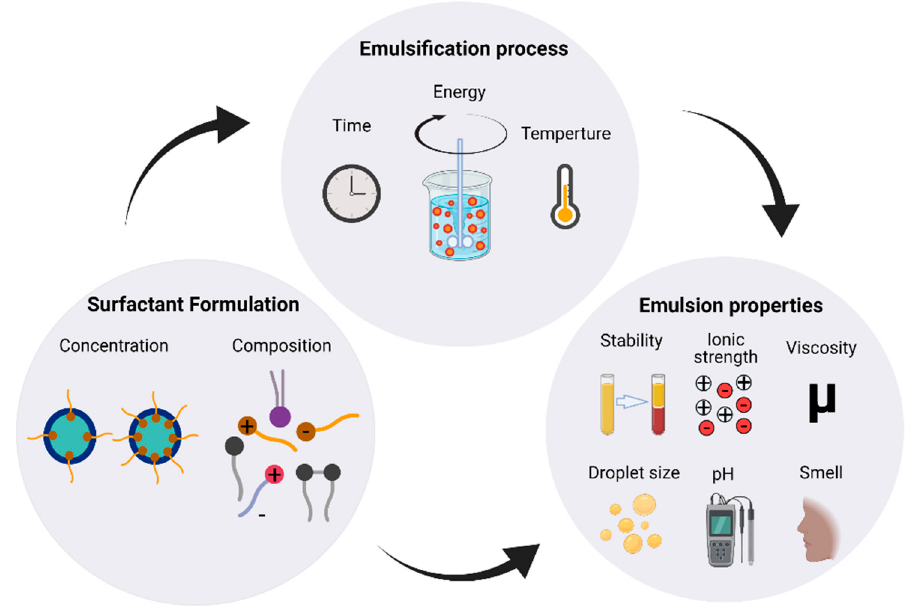
Figure 1. The relationship of the surfactant formulation with the other scales involved in the design of an emulsified product (formulation, process, and properties). The surfactant formulation variables (concentration and composition) are related to the emulsification process variables such as the emulsification time, energy incorporated into the emulsion, and temperature. Additionally, the emulsion properties also depend on the surfactant formulation and the emulsification process variables (created with BioRender®, San Francisco, CA, USA).